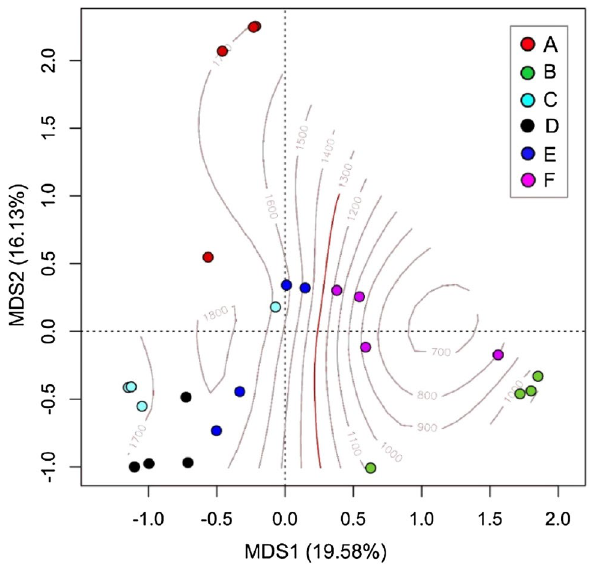
Figure 2. MDS of the phytosociological relevés. Capital letters indicate the six sampling areas, the 1.300 m a.s.l. contour line that separates sub-montane belt and high mountain belt vegetation is highlighted in